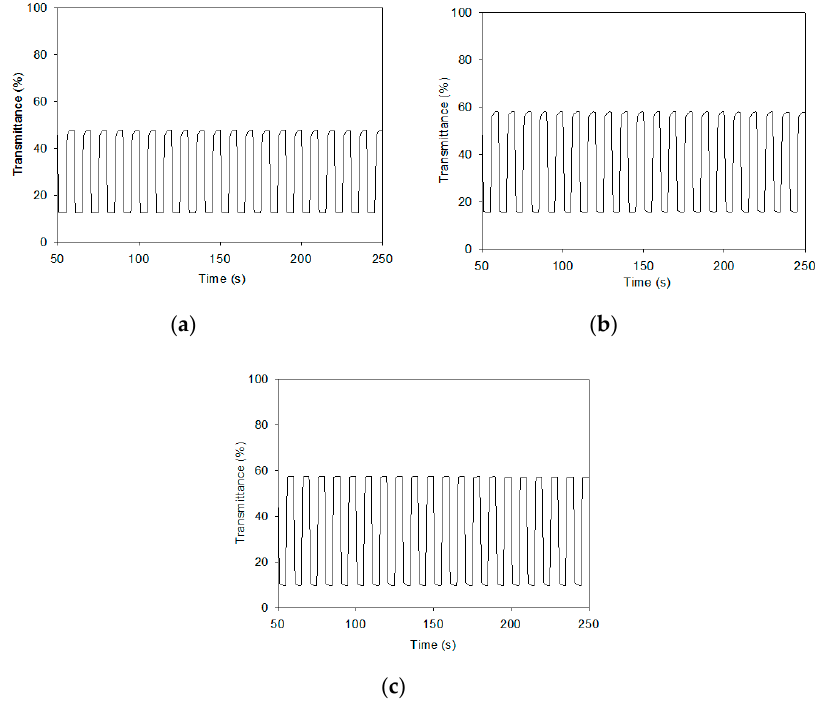
Figure 10. Transmittance of: ( a ) PTTPP / PProDOT-Et 2 ECD at 588 nm (between − 0.2 and + 1.0 V); ( b ) P(TTPP- co -DTC) / PProDOT-Et 2 ECD at 590 nm (between − 0.4 and 1.4 V); and ( c ) P(TTPP- co -DTP) / PProDOT-Et 2 ECD at 592 nm (between − 0.4 and 1.4